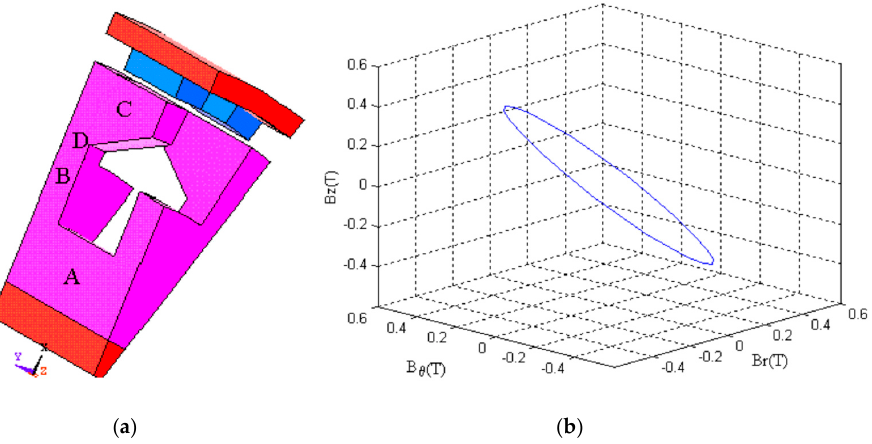
Figure 2. Magnetic field finite element analysis: ( a ) one pole-pitch for numerical analysis, and ( b ) magnetic flux density locus at Point C when the rotor has rotated by 360 electrical degrees.